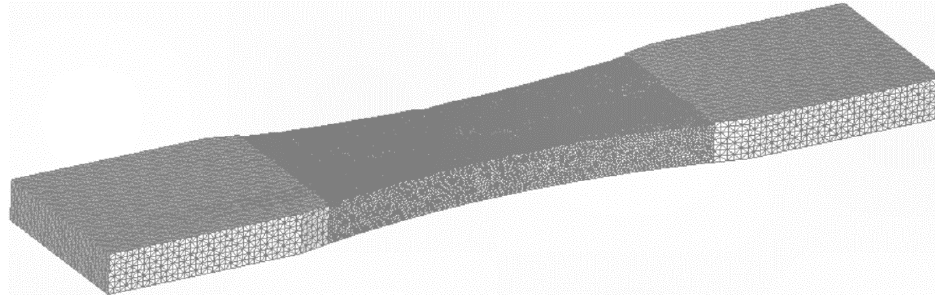
Figure 9. The coarse mesh, 300,233 ten nodded iso-parametric tetrahedral elements and 437,380 nodes.